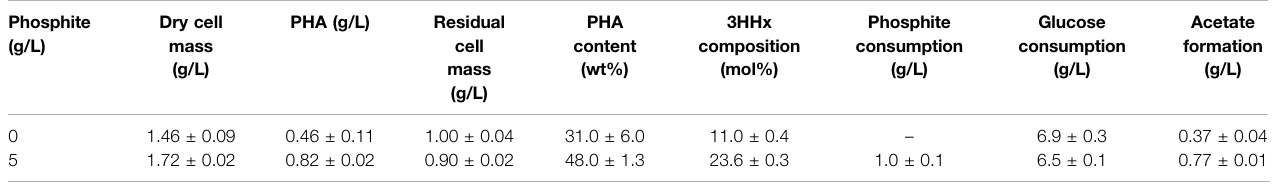
TABLE 2 | Effects of the phosphite oxidation system on P(3HB- co -3HHx) biosynthesis from glucose by two-stage cultivation of E. coli JM109 harboring pBKS-PCJAB/ pBtac-CJ Re E/pSTV-HCB/pMW-Gm-ptxD EAAR ABC.